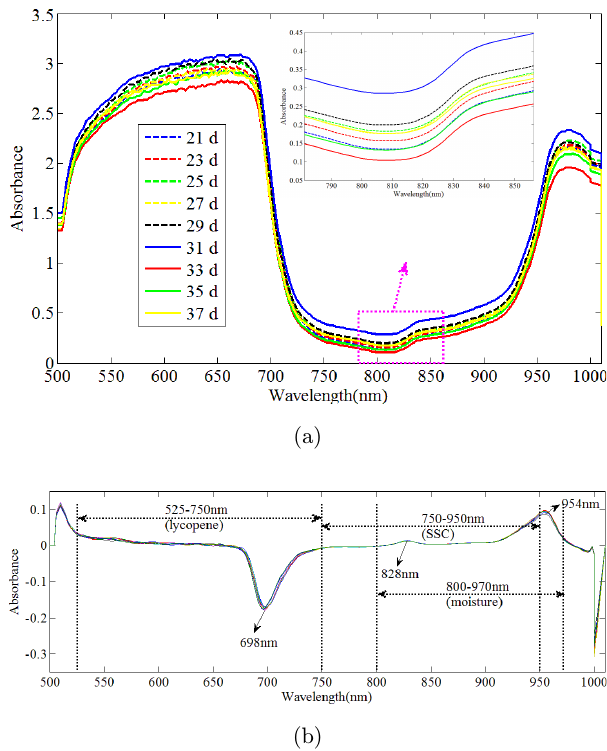
Fig. 3. Change of the average quality traits after standardized with error bars of 95% con¯dence interval during ripening period of watermelon.